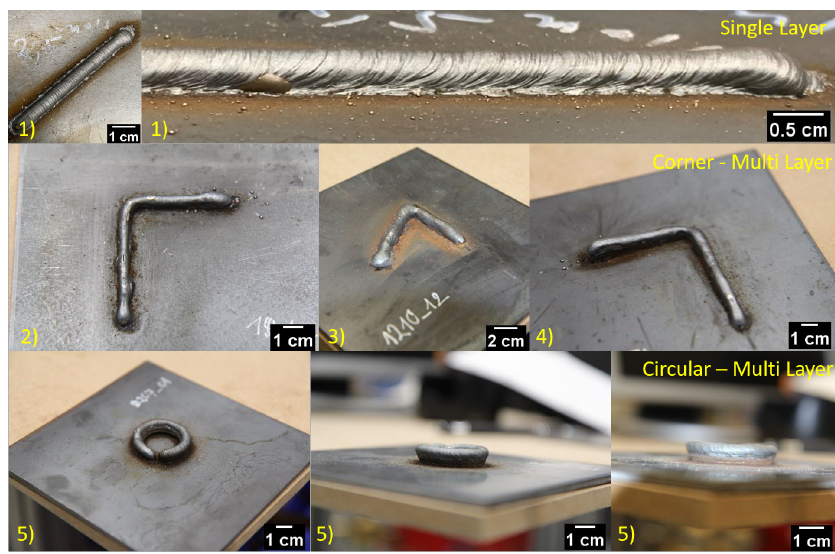
Figure 11. Single- and Multiilayer trajectories built using WAAM With Pure Object